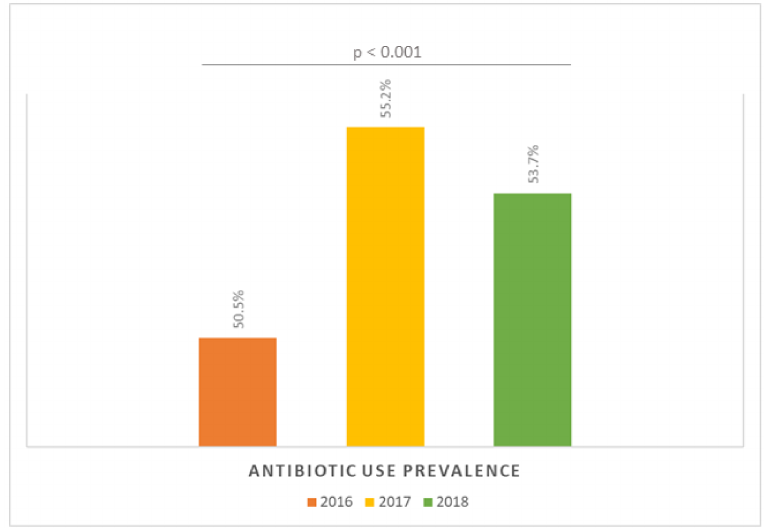
Figure 3. Prevalence of antibiotic use by year of the Point Prevalence Survey.